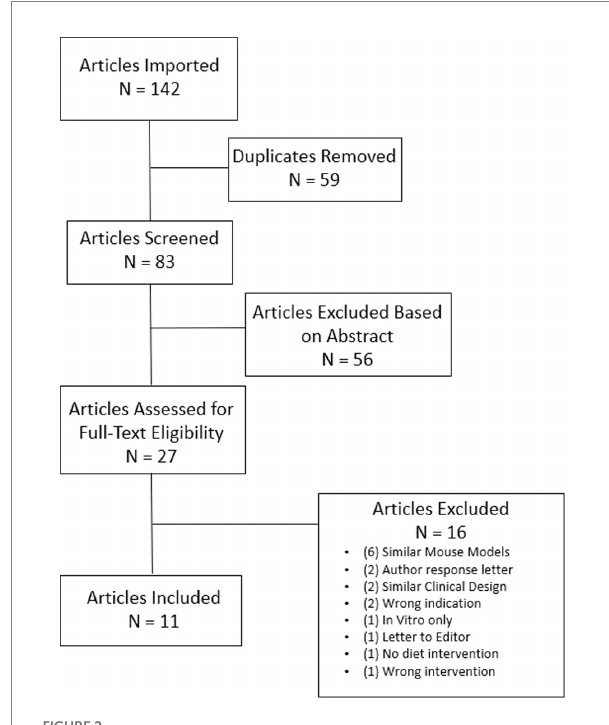
FIGURE 2 Flow diagram of search process. N is an abbreviation for